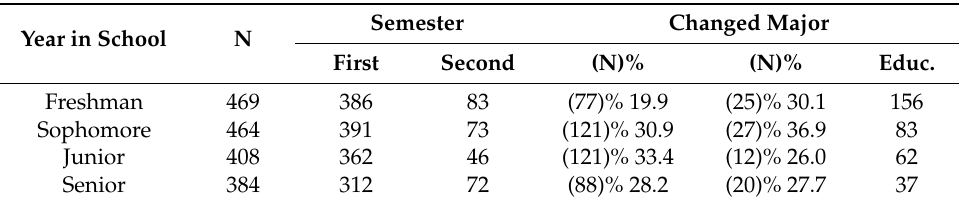
Table 5. Students changing majors (N = 1725).